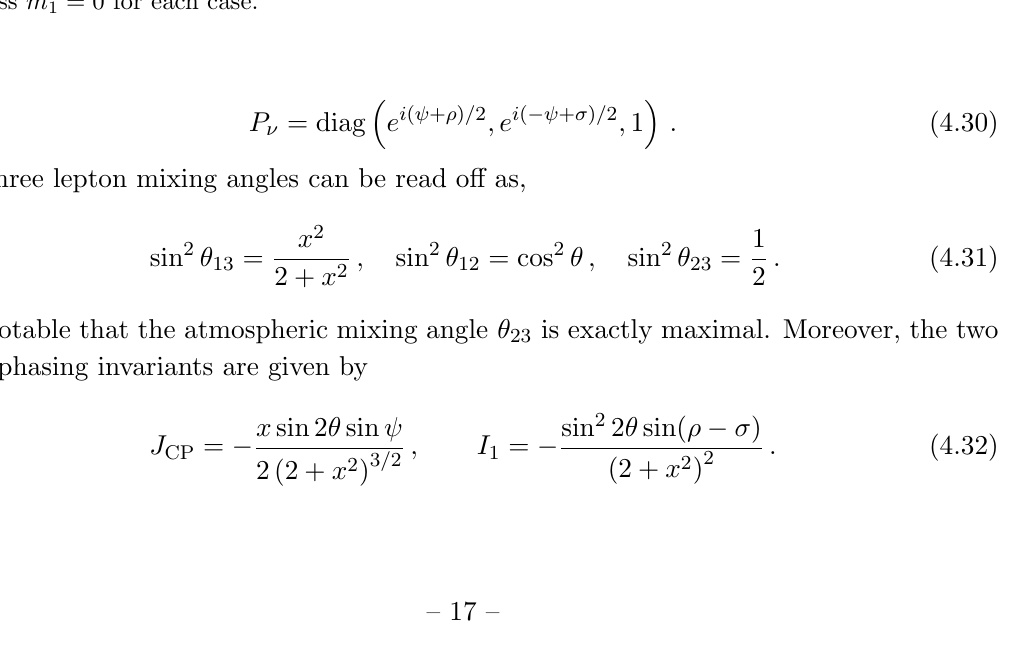
Table 1 . The best (cid:12)t values of the lepton mixing angles, CP violation phases (cid:14) CP and (cid:12) , and the neutrino masses m 2 and m 3 for some typical values of x and (cid:17) in new variants of Littlest seesaw model arising from the tri-direct CP approach with S 4 . The predictions for the e(cid:11)ective Majorana mass m ee are listed in the last column. We would like to remind that the lightest neutrino is massless m 1 = 0 for each